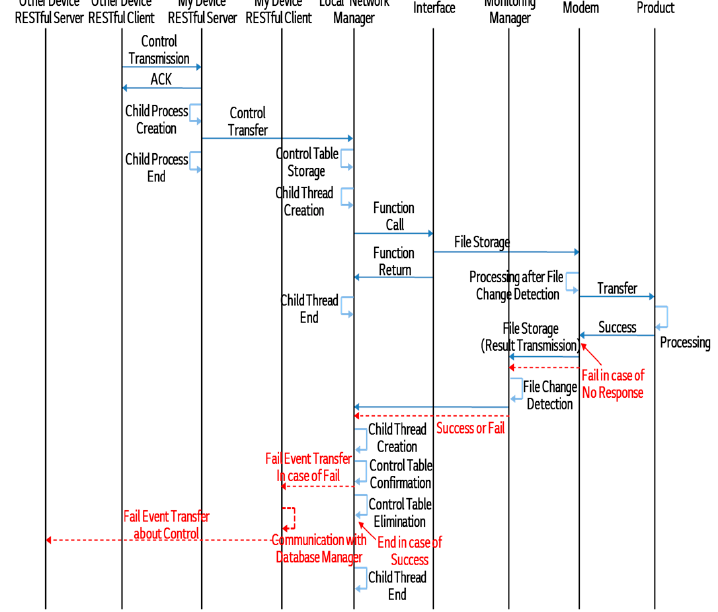
Figure 4. Protocol for receiving and processing control commands.